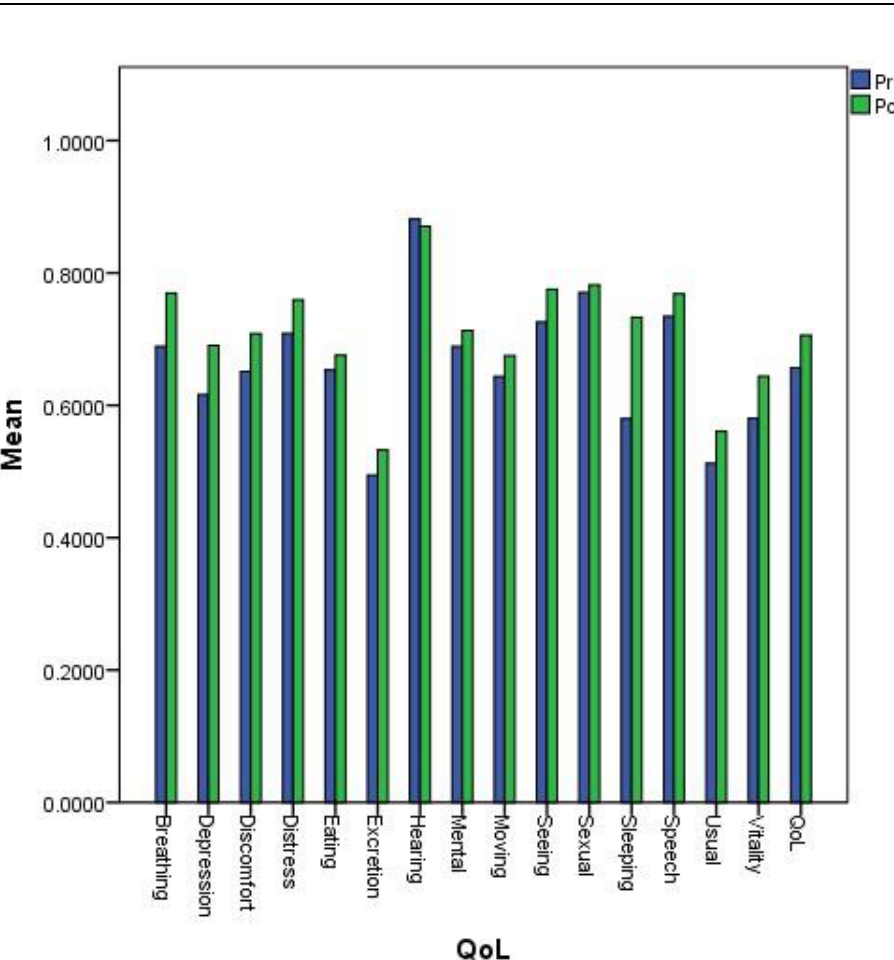
Figure 1. Mean values of the 15 dimensions determining Quality of Life (QoL) before and after a new